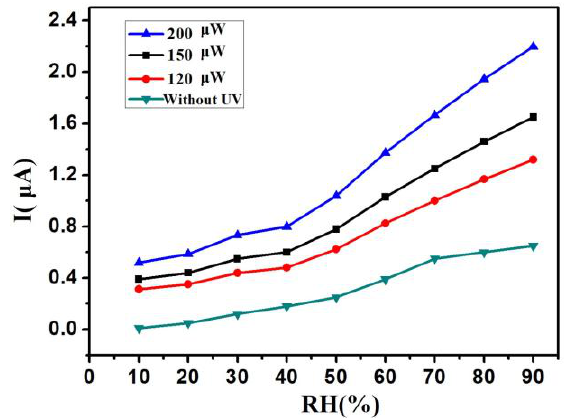
Figure 5. The I-RH curves at an applied voltage of 1 V with different UV power from 120 μW to 200 μW in the same wavelength, 300 nm, and without UV irradiation.